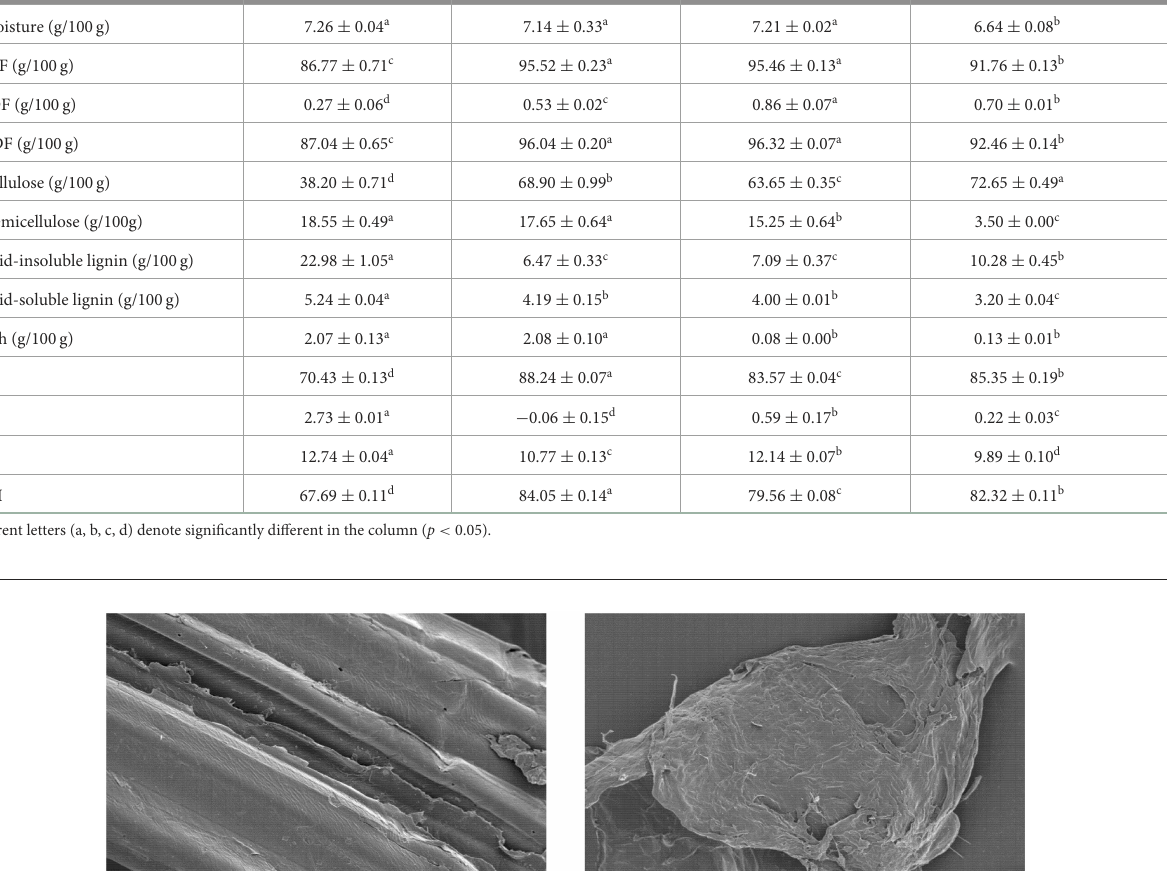
presence of non-dietary fiber impurities in rice bran dietary fiber. H-BIDF showed the highest WHC (14.95 g/g) and OHC (11.12 g/g), mainly due to the significant degradation of lignin